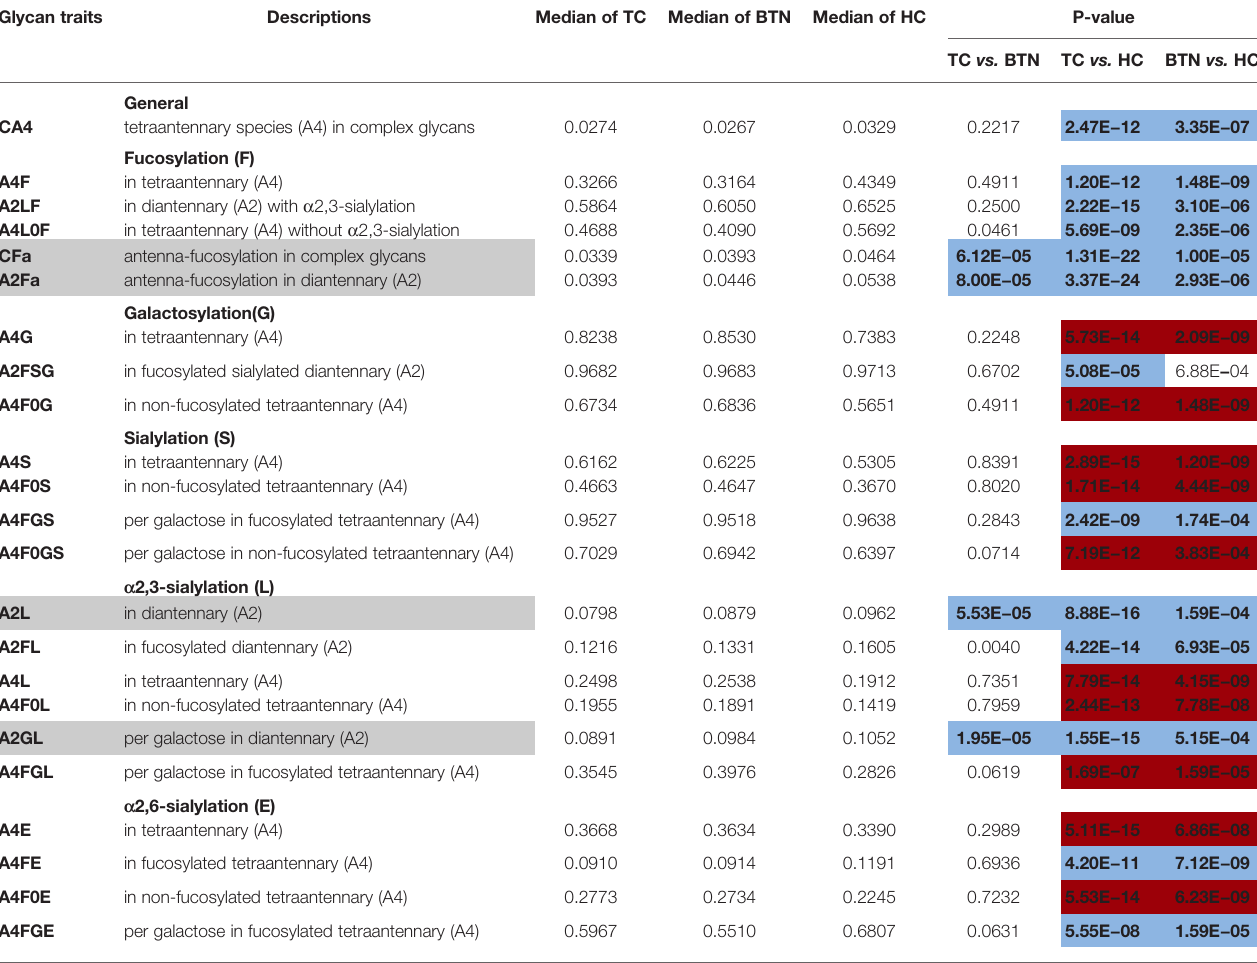
TABLE 2 | Differentially expressed derived glycan traits contributing to distinguishing between groups of patients with thyroid diseases and healthy controls. Glycan traits